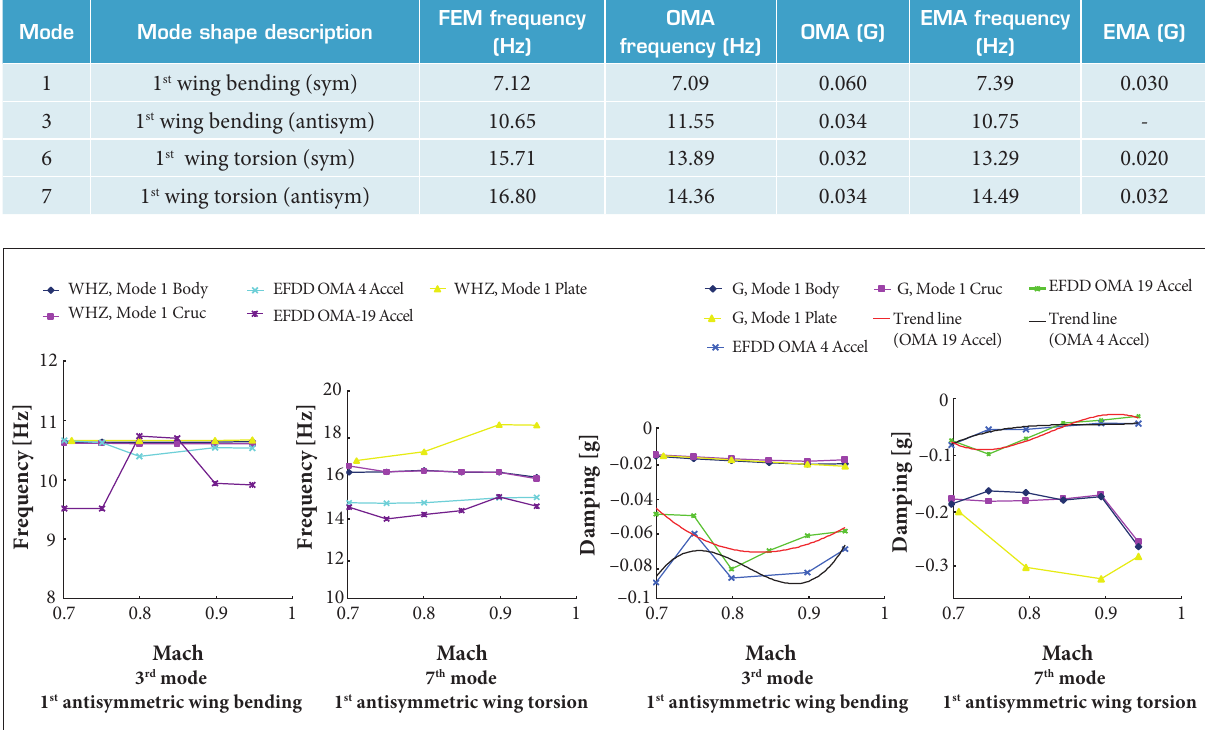
Figure 12. Antisymmetric modes.